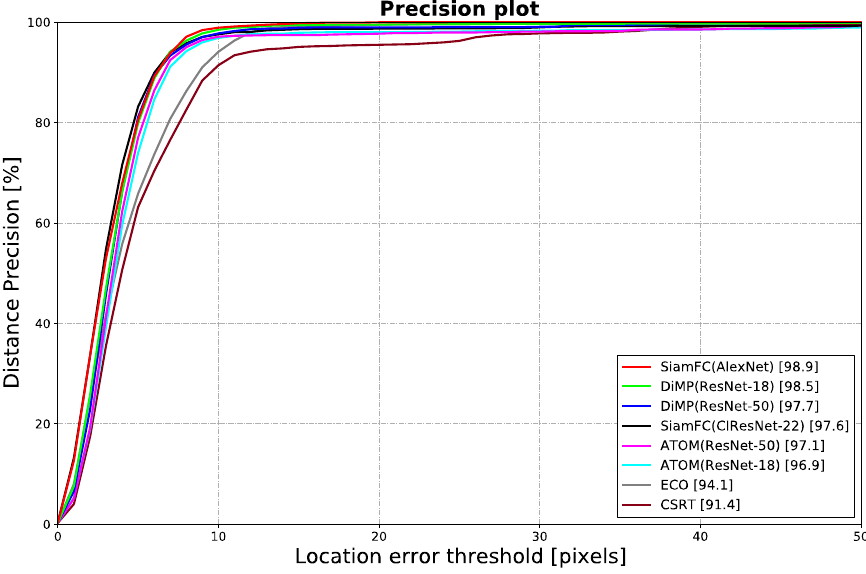
Figure 6. Precision plot shows the mean distance precision of 10 test sequences in full-length at different location error thresholds. The legend shows the precisions of different trackers at the threshold of 10 pixels.